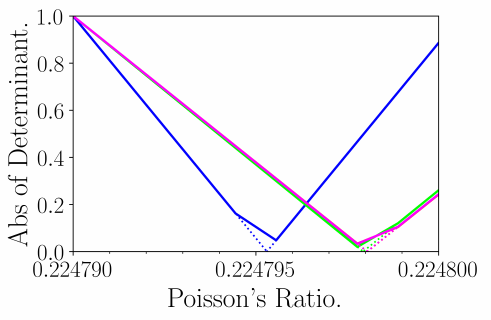
Figure 10. The absolute value of the determinant of the collocation matrix, excluding the propagating mode, for different numbers of corner modes. The respective lines correspond to four Lamb modes and M = 4 ( ), M = 6 ( ), M = 8 ( ), and M = 10 ( ) corner modes. The dotted lines are the projected values of the determinant, found by extending the curves on either side of zero; this aids the determination of location of zero. The value of Poisson’s ratio at which the determinant vanishes can be seen to have converged, once M = 6 or larger, to ν ≈